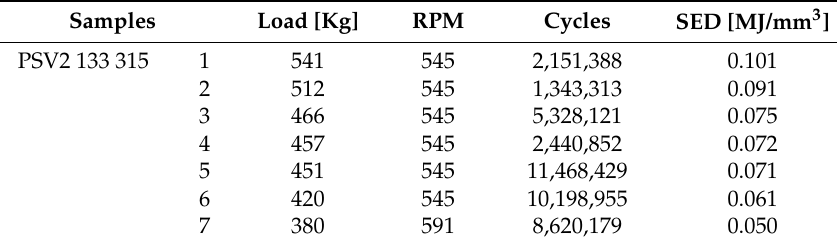
Table 2. Fatigue data for the roller PSV2 133 315.